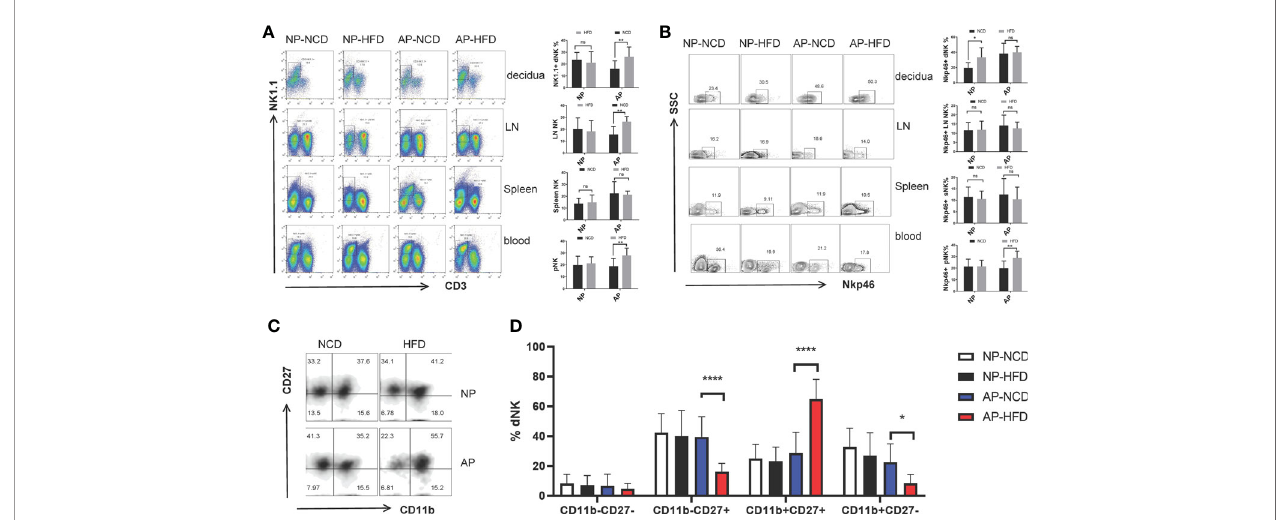
FIGURE 2 | Maternal obesity exerts differential effects on NK cells in NP and AP mice. On gestational day 12.5 (GD12.5), cells from deciduas, lymph nodes (LN), spleens and blood were collected and analyzed by fl ow cytometry. (A) Representative and quantitative results for NK cells in the indicated tissues derived from NP and AP models with NCD or HFD fed. (B) Representative and quantitative results for NKp46 expression in NK cells. (C) Representative fl ow cytometry results for CD27 and CD11b expression in decidual NK cells. (D) Proportions of CD11b − CD27 − , CD11b − CD27 + , CD11b + CD27 + and CD11b + CD27 − NK cell subsets in the deciduas. Data are presented as mean ± SEM. NS, not signi fi cant; *p < 0.05, **p < 0.01, ****p <